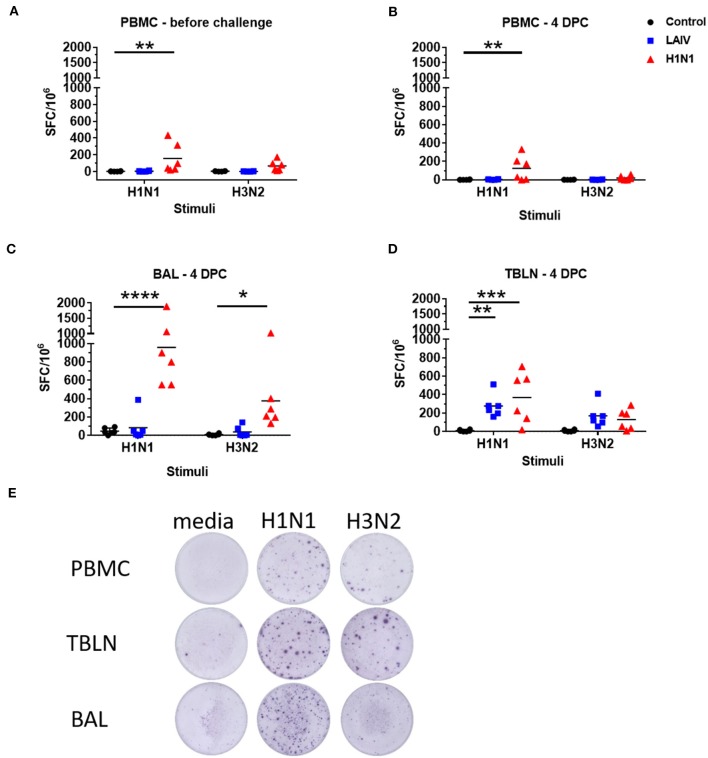
Numbers of IFNγ spot forming cells (SFC) in PBMC (A,B), BAL (C), and tracheo-bronchial lymph node (TBLN) (D) were determined by ELISpot following stimulation with wt H1N1 or wt H3N2 viruses in vitro. Results for wt H1N1 and wt H3N2 stimulation were expressed as number of IFNγ-producing SFC per 106 cells after subtraction of the average number of IFNγ-secreting cells in medium control wells. Representative images of the ELISPOT wells are shown in (E). Asterisks denote significant differences between the indicated groups *p < 0.05, **p < 0.05, ***p < 0.005, ****p < 0.0005 determined using two-way ANOVA with Dunnet's test for multiple comparisons.